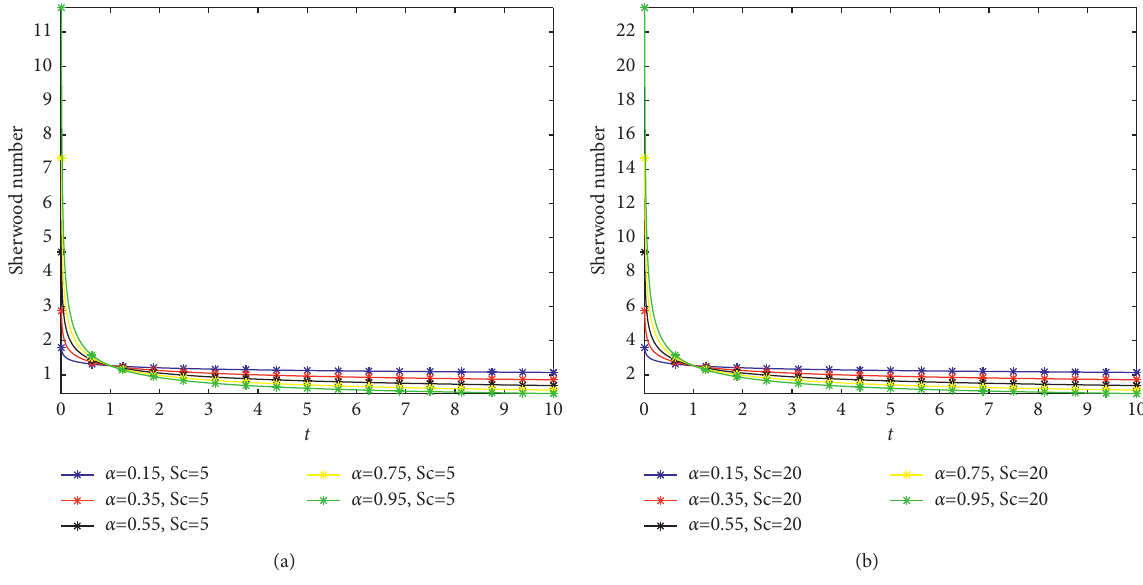
Figure 17: Sherwood number for different values of order α